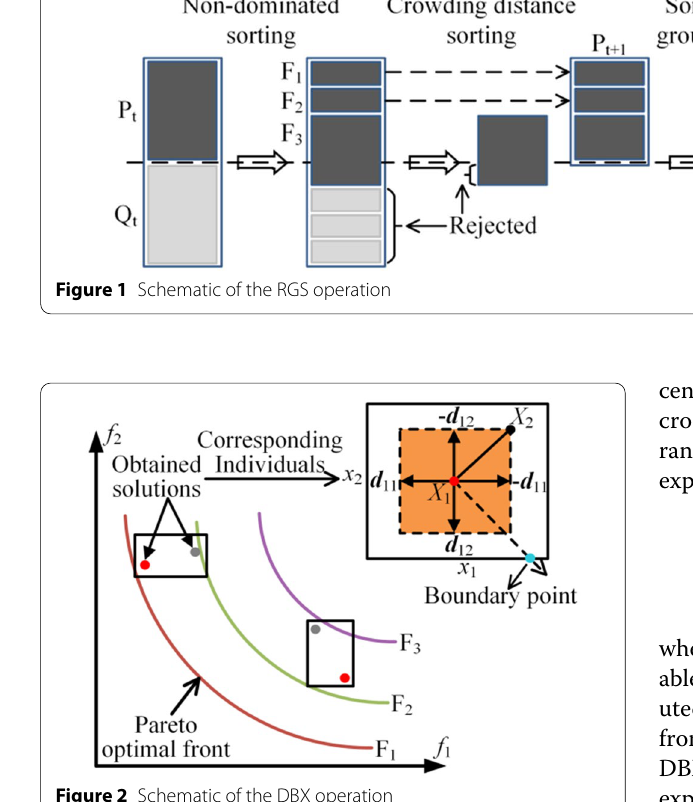
Figure 2 Schematic of the DBX